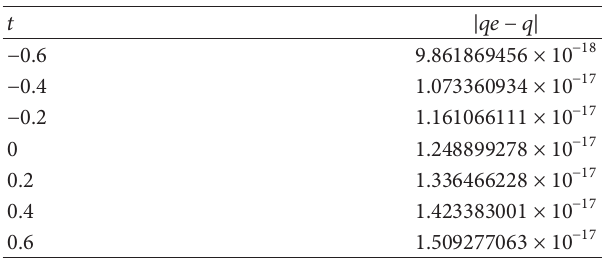
Table 1: The HPM results for 𝑞(𝑥,𝑦, 𝑡) in comparison with the analytical solution with initial conditions (5).